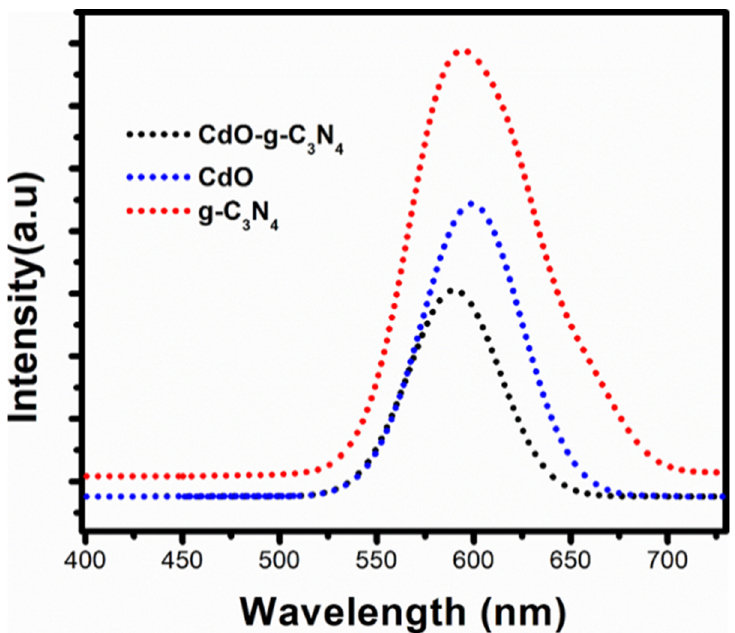
Figure 5. Photoluminescence spectroscopy of g-C 3 N 4 nanosheets, CdO nanorods, and CdO-g-C 3 N 4 nanocomposite.